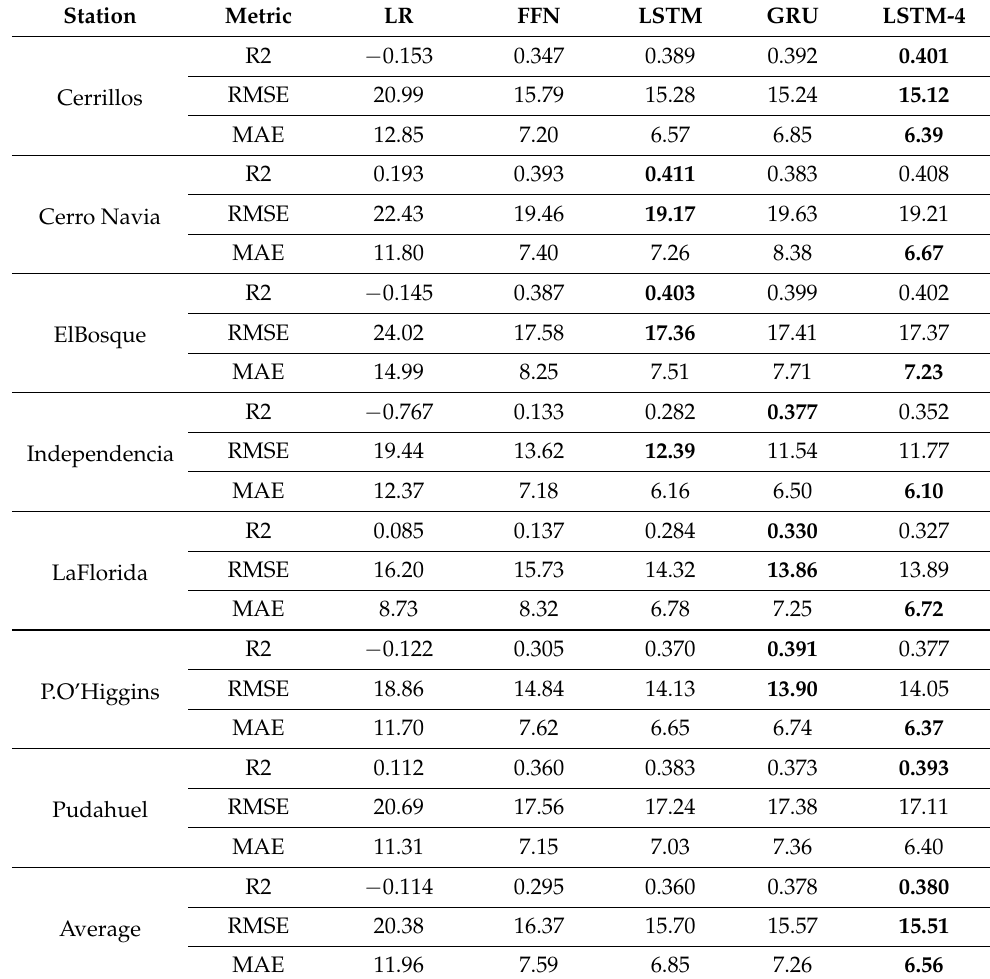
Table 9. Metrics of space-time prediction considering 7 stations, of 24 h in the future. Bold font indicates best